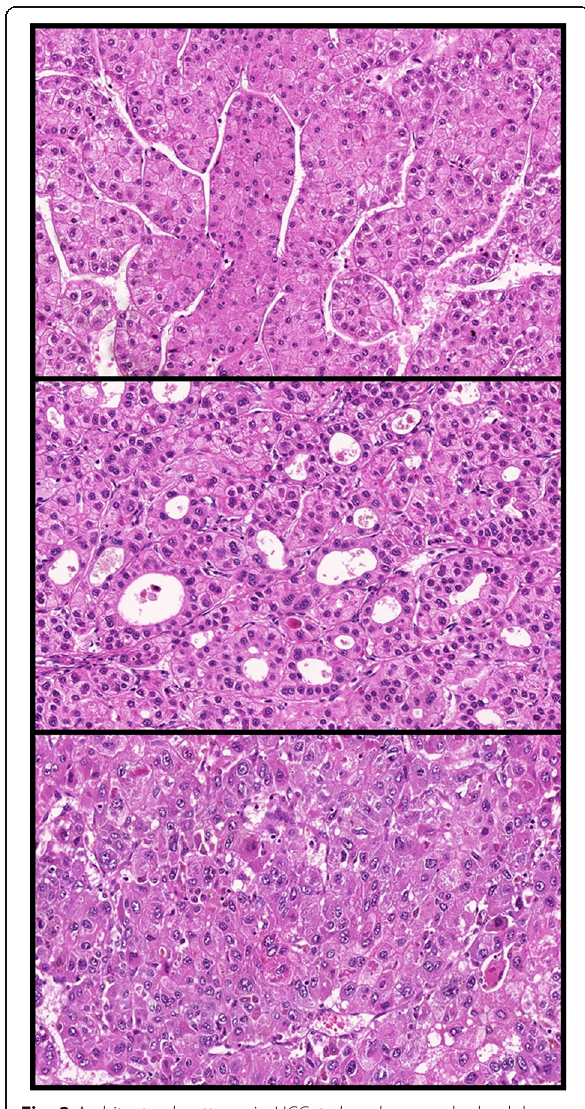
Fig. 2 Architectural patterns in HCC: trabecular, pseudoglandular and solid (from top to